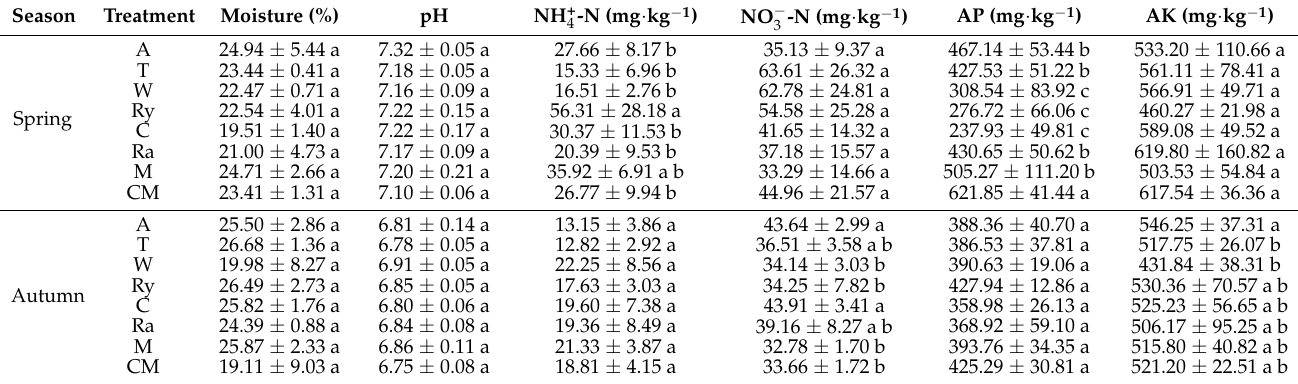
Table 1. Effects of different intercropping systems on soil physicochemical properties at two sampling times. Season Treatment Moisture